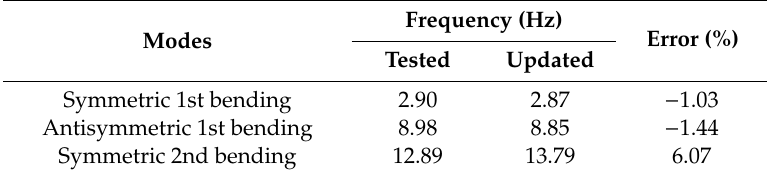
Table 4. Comparison of revised theoretical analysis result and GVT